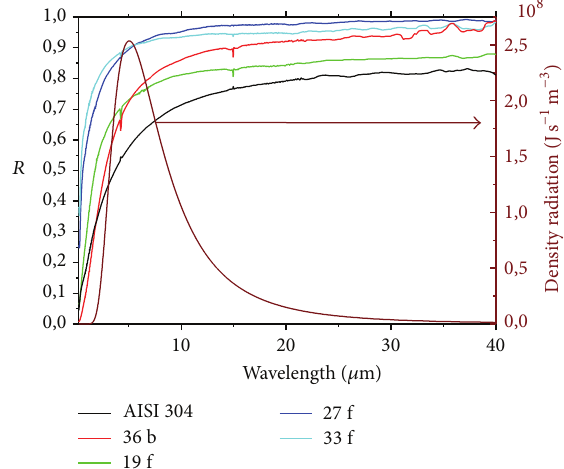
Figure 7: Comparison of specular reflectance spectra of the bare substrate (AISI 304), Wood-treated (36 b), and Watts-treated sam- ples (19 f, 27 f, 33 f). In the picture the blackbody spectrum at 300 ∘ C is also shown in wine